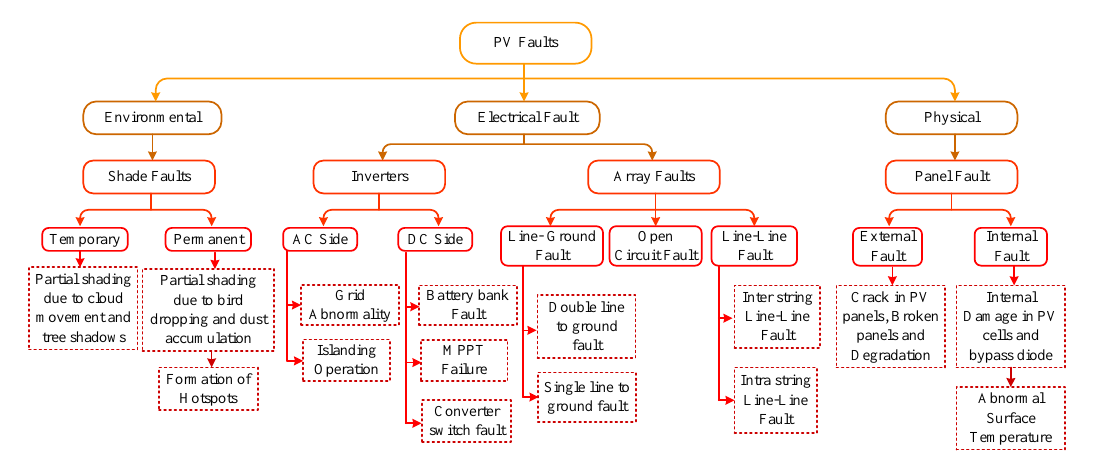
Figure 2. Faults in a photovoltaic system. Table 1. Fault Mode and their potential causes and effects.